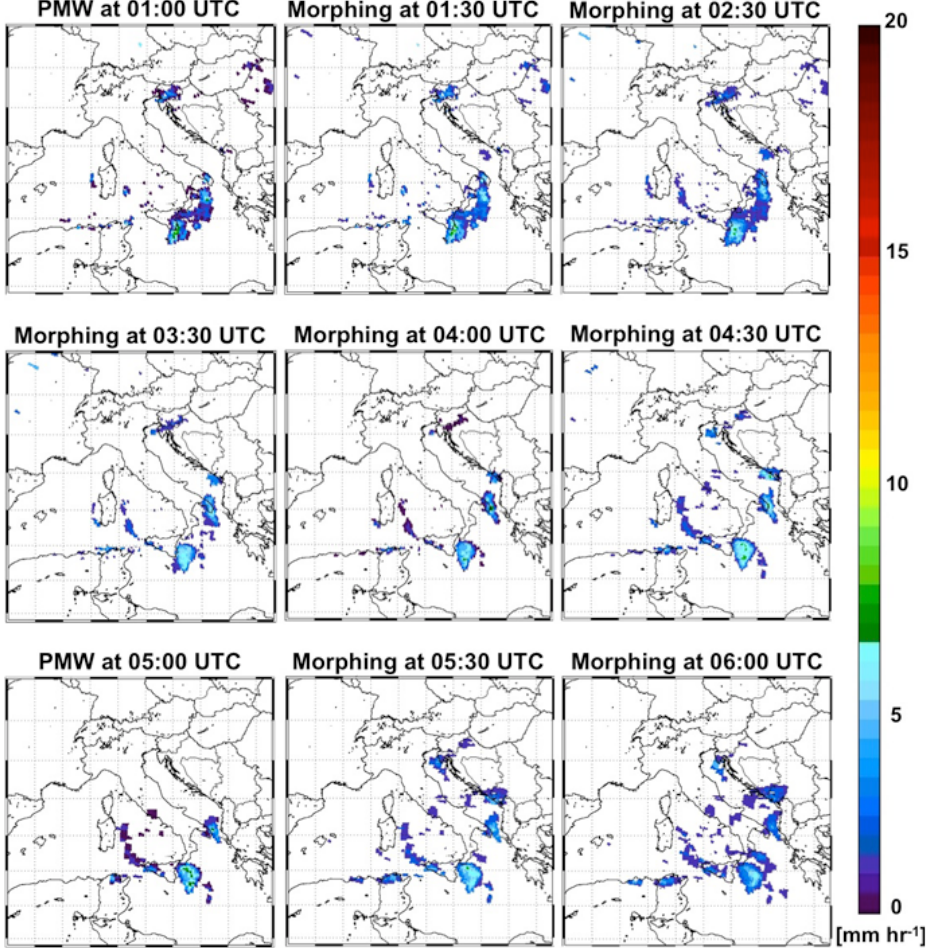
Fig. 4. Example of CMORPH algorithm applied to PMW precipitation intensities retrieved by 183-WSL algorithm of Laviola and Levizzani (2008, 2009, 2011) for a severe storm over southern Italy during October 2009. PMW rain rates at 01:00UTC are “morphed” to successive PMW rain-rate estimates at 05:00UTC. Note that the last two panels, representing CMORPH outputs at 05:30 and 06:00UTC, respectively, are used to describe CMORPH reconstruction of the rain field between PMW rain rates at 05:00 and